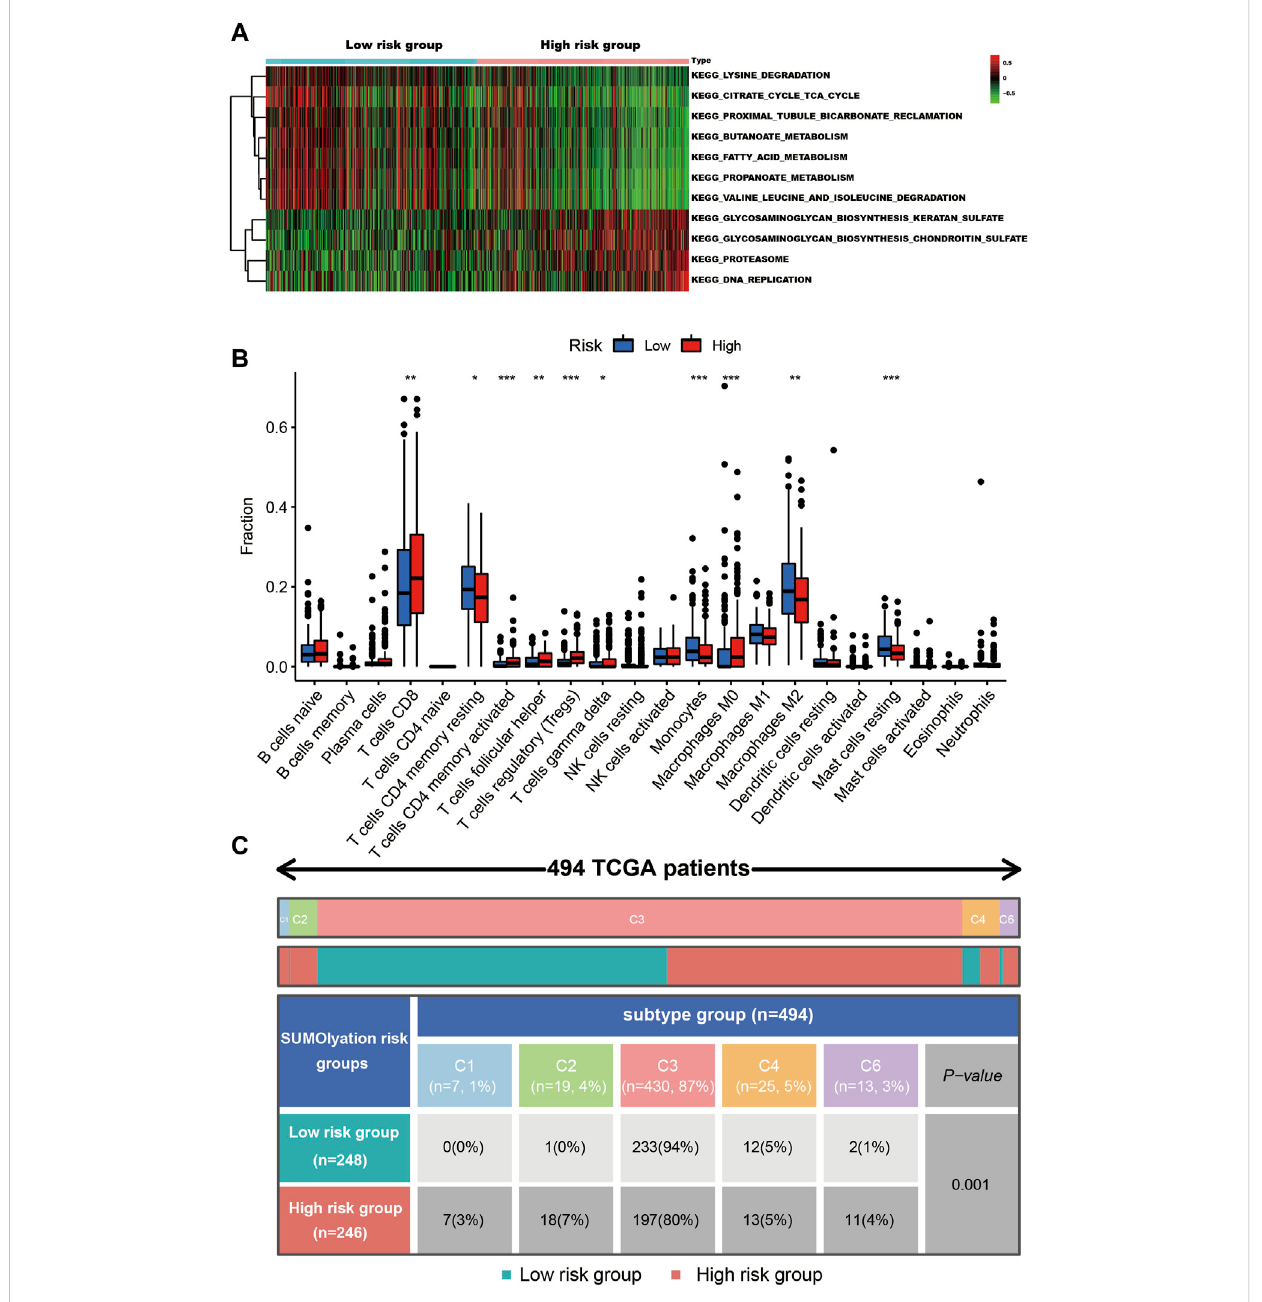
FIGURE 6 The cell signaling and immune status in the different risk groups of kidney cancer tissues. (A) The GSVA analysis shows seven pathways were up- regulated in the low-risk group, while four pathways were up-regulated in the high-risk group. (B) The different types of immune cells in fi ltrated in the tumor tissues, *** indicates p < 0.001, ** indicates p < 0.01, and * indicates p < 0.05. (C) The patients ’ immune subtypes in the different risk groups. C1 (wound healing), C2 (IFN-g dominant), C3 (in fl ammatory), C4 (lymphocyte depleted), and C6 (TGF-b